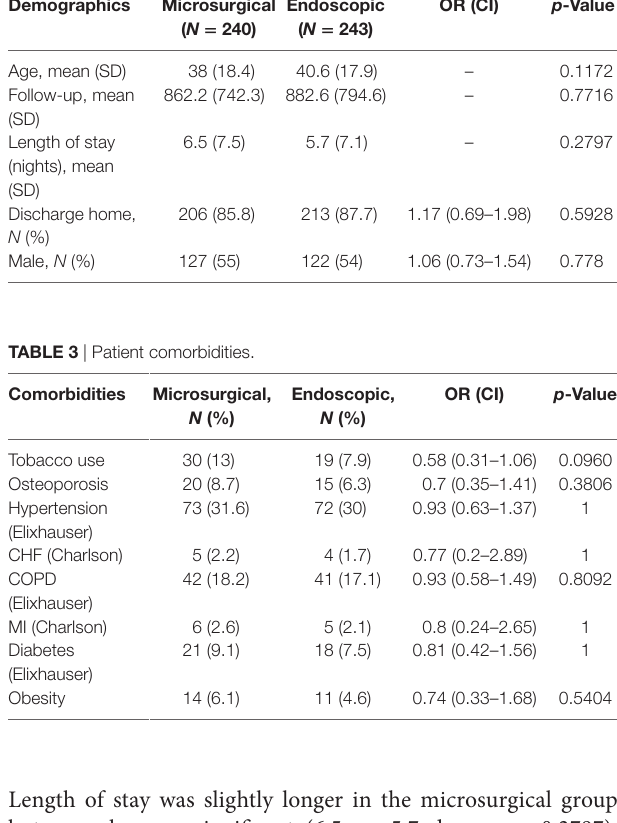
Table 1 | International Classification of Disease version 9 (ICD-9) and Current Procedural Terminology (CPT) codes used to identify cohort, comorbidities, and complications.